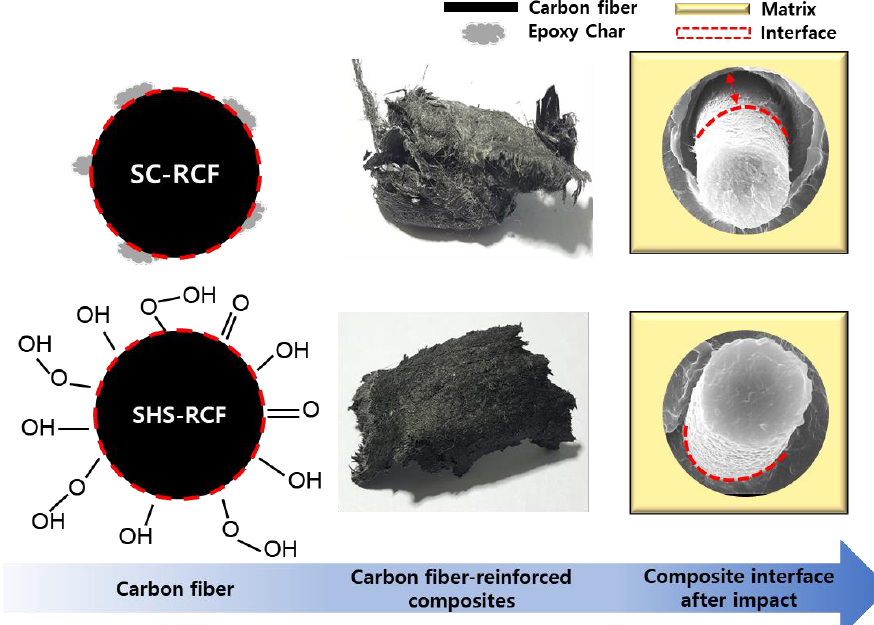
Figure 4. A schematic of interfacial adhesion changes of carbon fibers by recycling